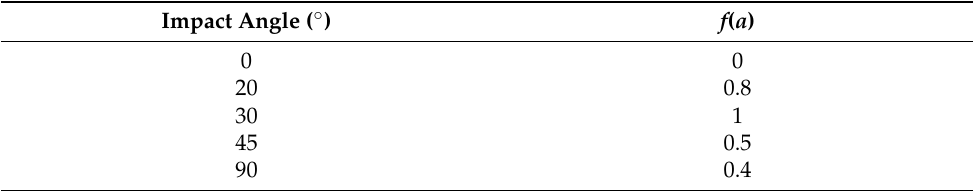
Table 1. Impact angle function